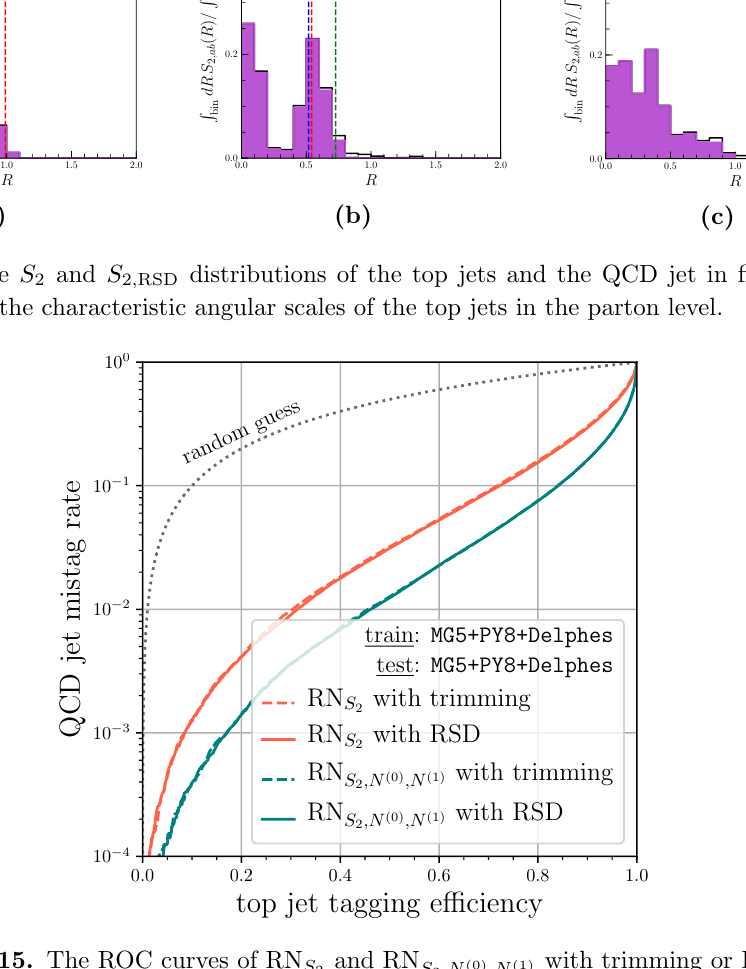
and RN with trimming or S 2 ;N (0) ;N (1) 2